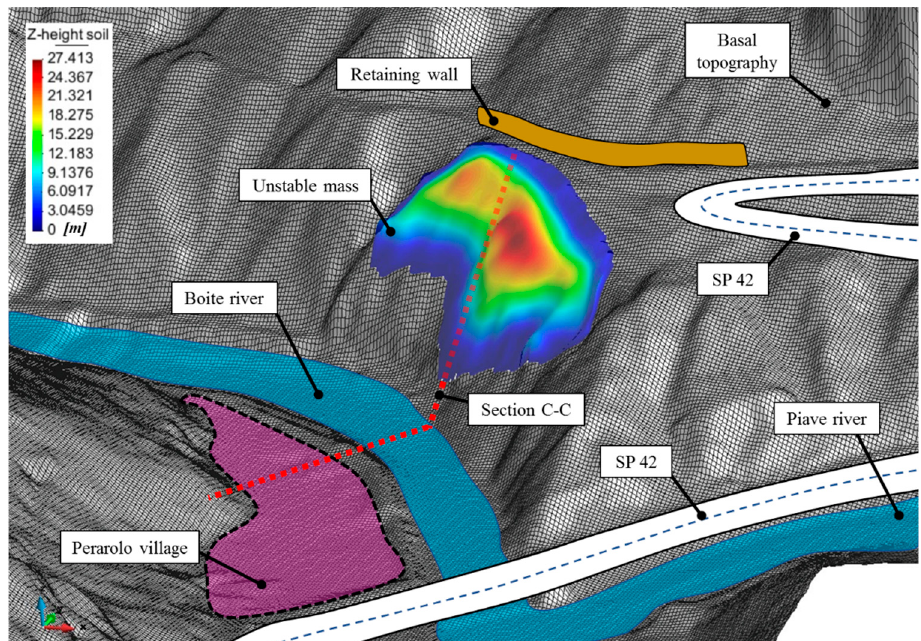
Figure 9. Three-dimensional (3D) visualization of the SPH model in which the basal topography and the mesh of the unstable mass are represented. The figure shows the model geometry and the unstable volume, with the position of the most important details.